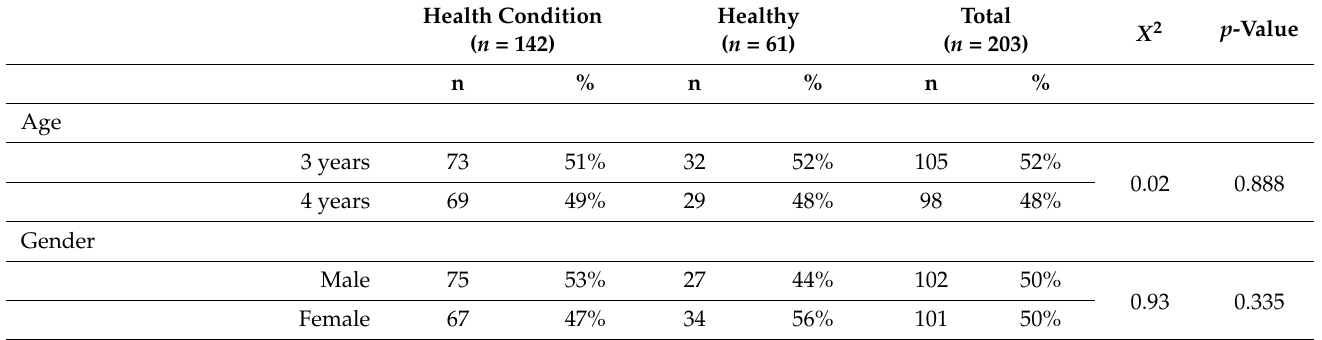
Table 1. Descriptive statistics of the sample (Total Sample N =